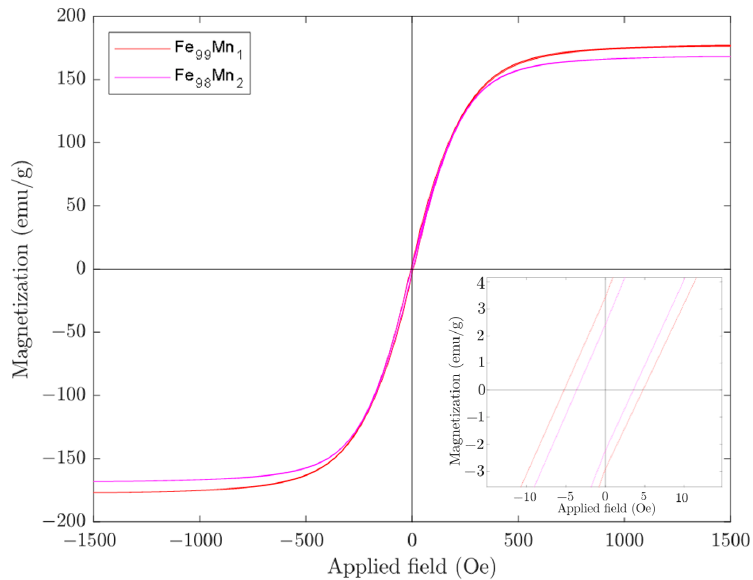
Figure 10. Magnetic hysteresis loops for samples Fe 99 Mn 1 and Fe 98 Mn 2 (room temperature). The effects of B on the magnetization are clear for the value of the saturation. Clearly, by adding B to the alloy, the atomic percentage of non-magnetic elements increases. Because of this, the saturation magnetization decreases as the atomic percentage of B increases. The other parameters in Table 3 do not follow this tendency. As stated in Table 3, the values of coercivity and remanent magnetisation are higher for sample B15 than for sample